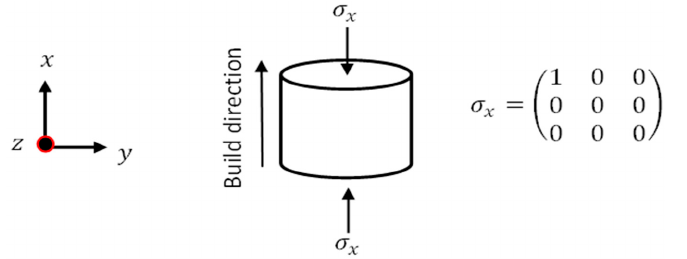
Figure 7. Schematic diagram illustrating the specimen loading axis and corresponding second-rank stress tensor.